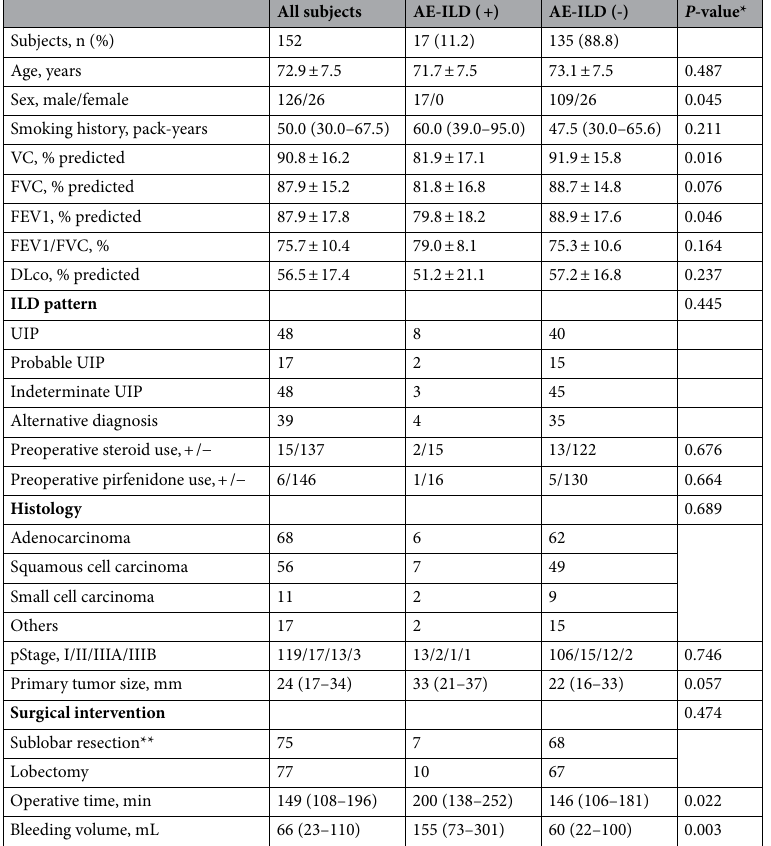
Table 1. Baseline characteristics. Data are presented as mean ± standard deviation or median (interquartile range) according to their distribution. AE-ILD acute exacerbation of interstitial lung disease; DLco diffusing capacity for carbon monoxide; FEV1 forced expiratory volume in one second; FVC forced vital capacity; ILD interstitial lung disease; UIP usual interstitial pneumonia; VC vital capacity. *All P- values were evaluated by comparing patients with and without postoperative AE-ILD using the t-test and Mann–Whitney U tests for normally and non-normally distributed variables, respectively, and using Pearson’s chi-squared test.